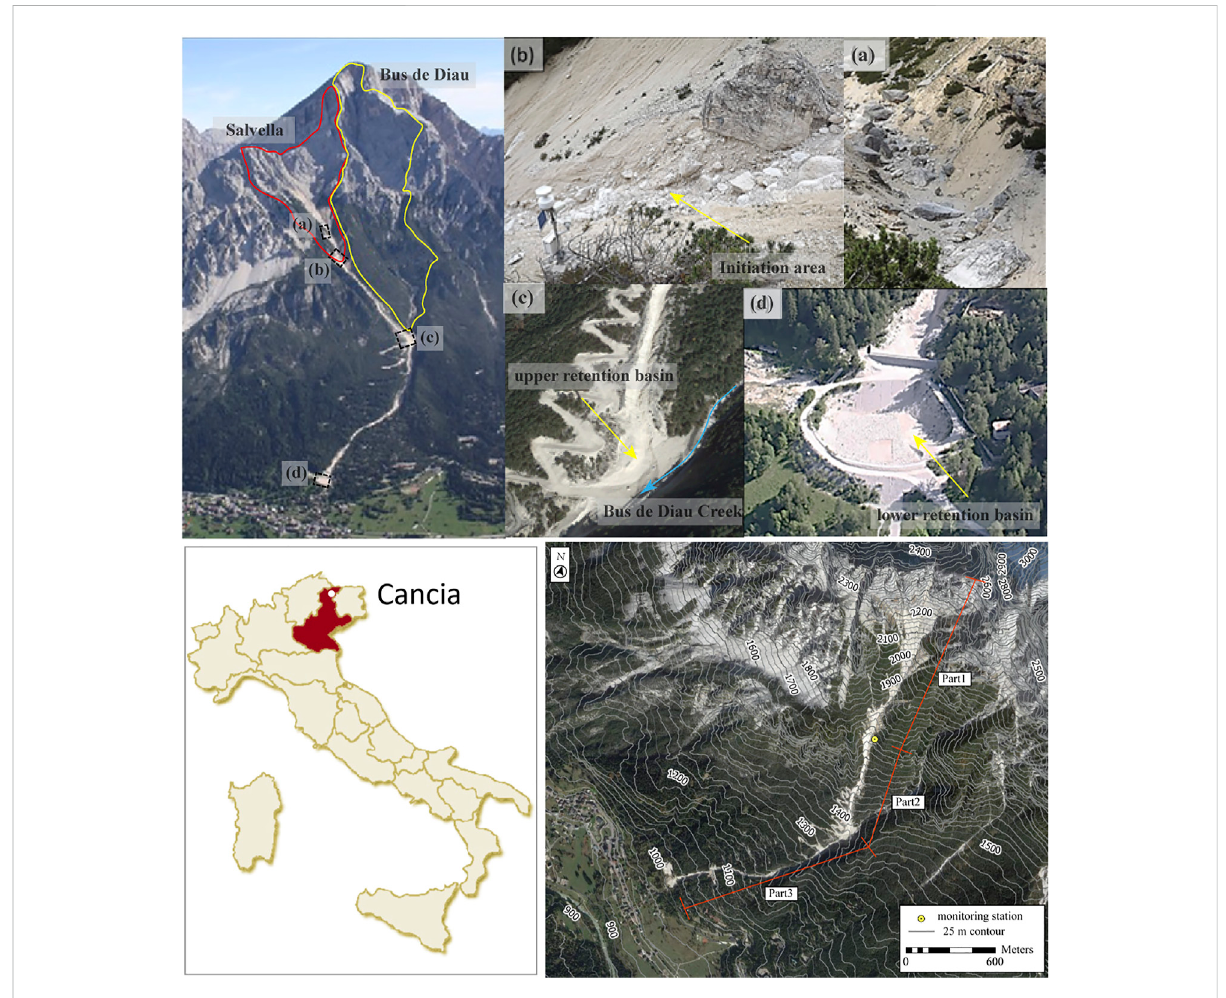
FIGURE 4 General view of theCancia debris- fl ow channel and basins (A) the debris fl ow channel in the upper part of the initiation area; (B) thelocation of the monitoring station; (C) the upper retention basin at 1,340 m a.s.l.; (D) the lower retention basin at 1,000 m